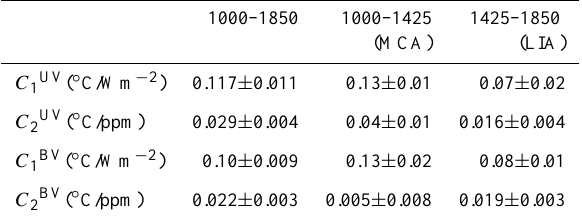
Table 2. Sensitivity coefficients to solar ( C 1 ) and CO 2 ( C 2 ) es- timated on the Northern Hemisphere temperature in SGI, on the whole preindustrial period, the MCA and the LIA. The indices UV and BV denote the methods to estimate the coefficients, i.e. univari- ate and bivariate regressions,